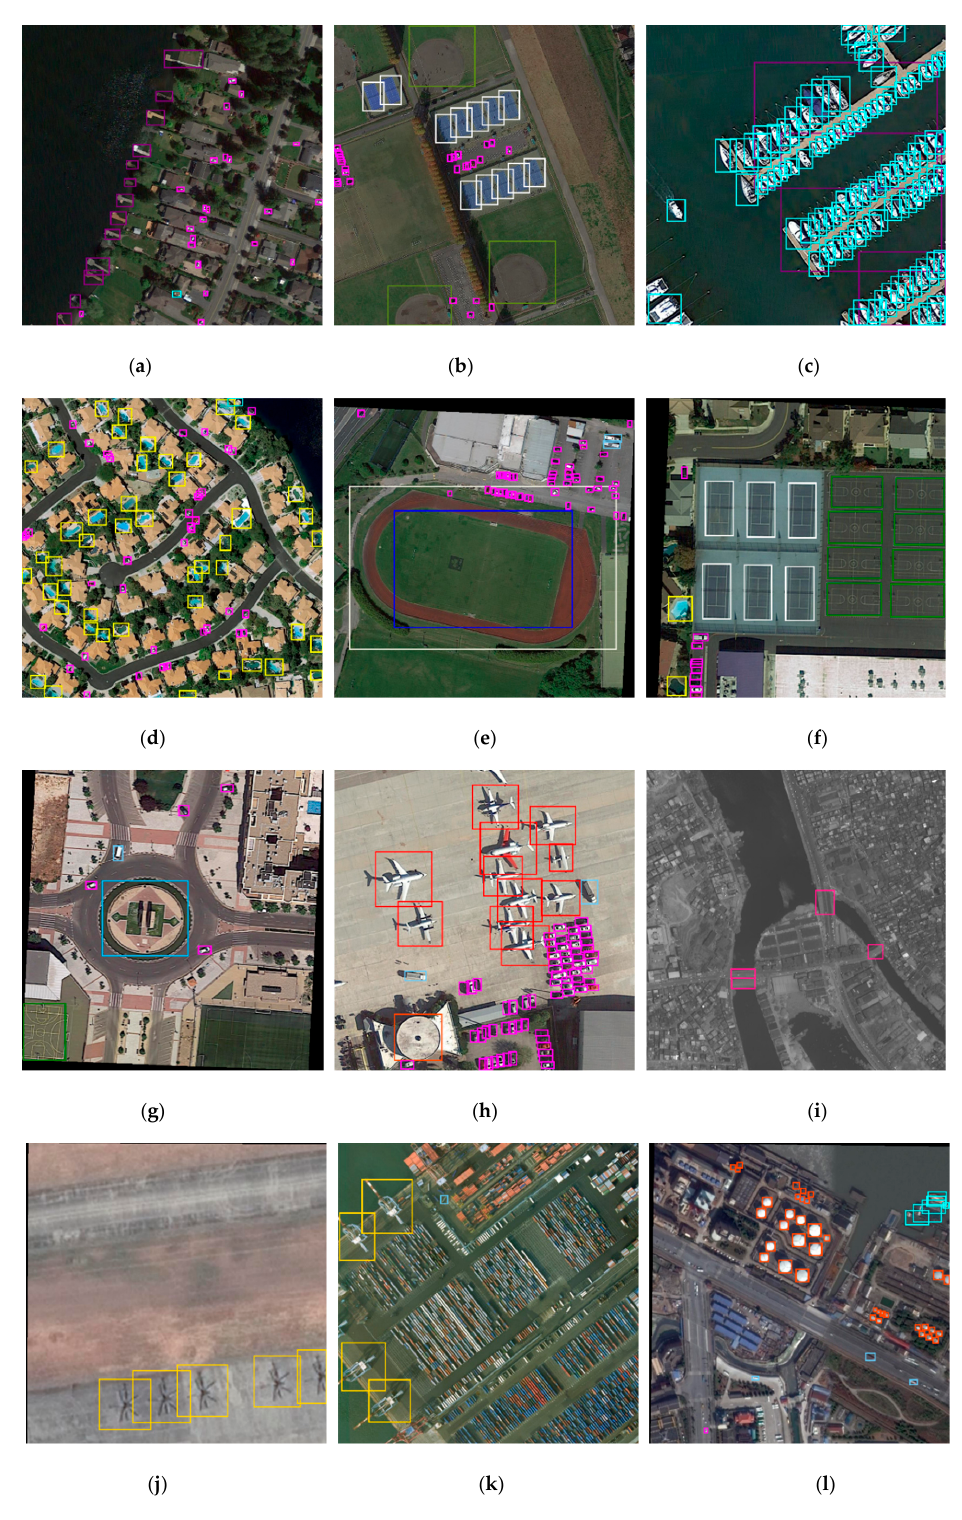
Figure 8. Visualization detection results for 16-classes on the DOTA-v1.5 test dataset. Main display categories: ( a ) harbor; ( b ) baseball diamond and tennis court; ( c ) ship and harbor; ( d ) swimming pool and small vehicle; ( e ) ground track field and soccer ball field; ( f ) tennis court and basketball court; ( g ) roundabout; ( h ) plane and lLarge vehicle; ( i ) bridge; ( j ) helicopter; ( k ) container-crane; ( l ) storage tank and ship.